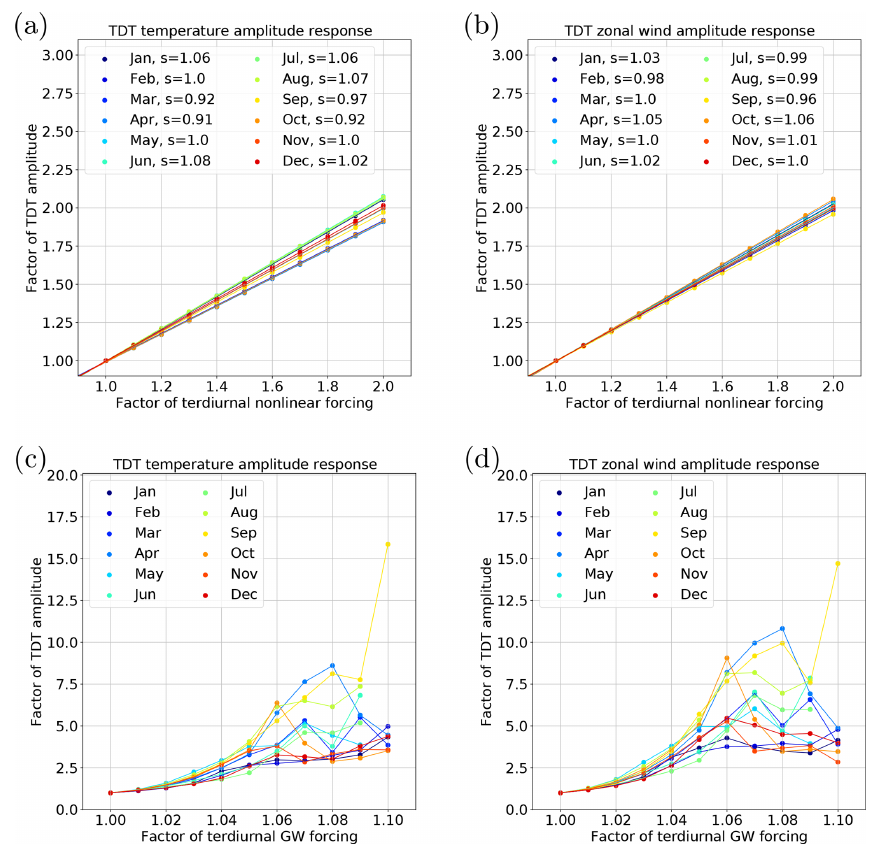
Figure 5. Normalized, horizontal mean vertical mean (80–160km height range) TDT amplitudes for temperature (a, c) and zonal wind (b, d) according to an increased terdiurnal forcing in NLIN 2000 (a, b) and GWF 2000 (c, d) . Different colors refer to different months. Dots denote specific simulations. For the enhancement of the nonlinear forcing (a, b) , a linear fit is added for each month (corresponding slope s : see